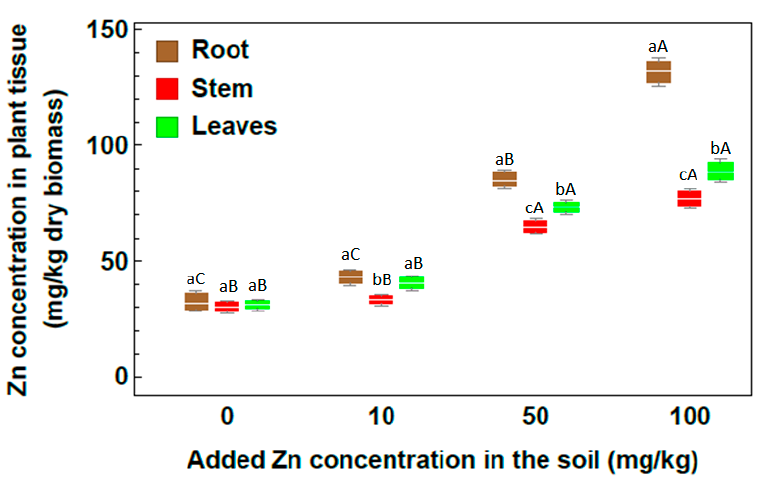
Figure 6. Concentration of Zn in plant organs of Rhazya stricta grown in soil treated with 10, 50 and 100 mg Zn/kg soil in an open greenhouse. Different lowercase letters indicate significant differences between plant parts for each soil metal concentration, and different capital letters indicate a significant difference between soil metal concentrations for each plant part ( p < 0.05).